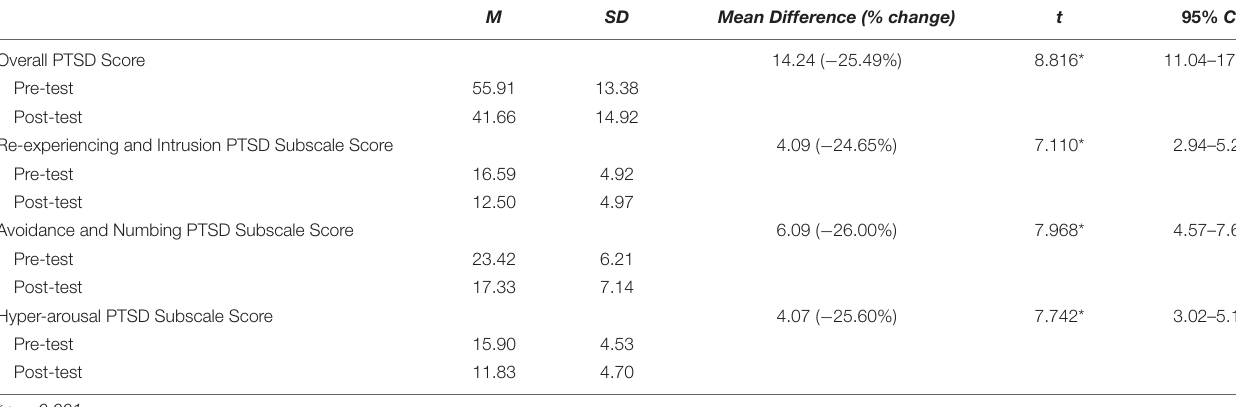
TABLE 1 | Results for the Paired-samples t -tests for PTSD and PTSD symptom subscale mean scores.